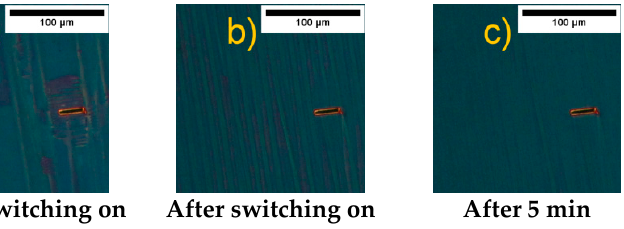
13.01, 18.82 and 16.90 nC/cm 2 for Composites 1–5, respectively. It turned out that even the